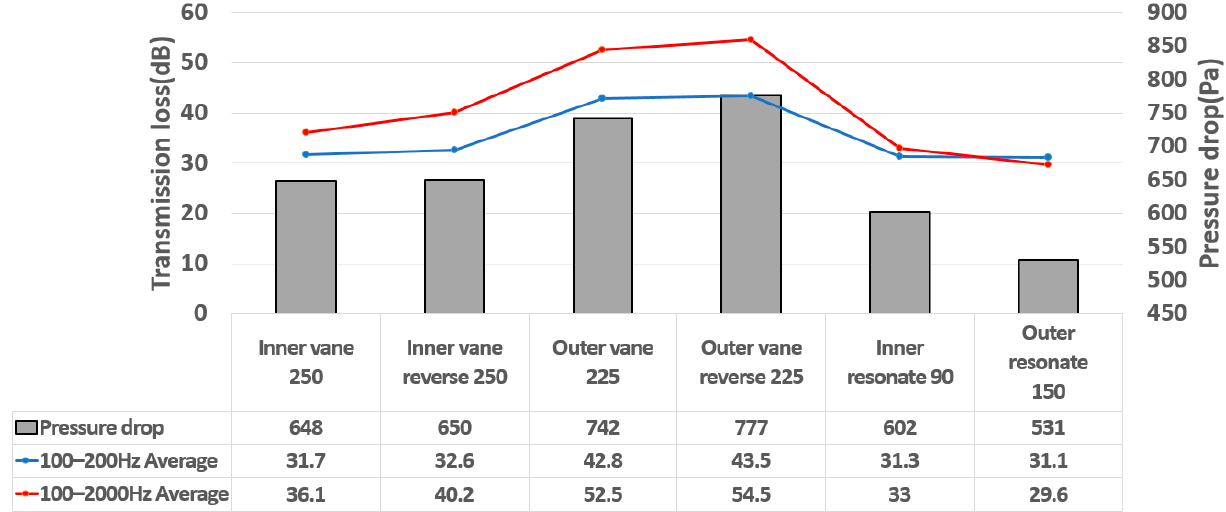
Figure 33. Averaged transmission loss and pressure drop according to the optimal cases for each type.